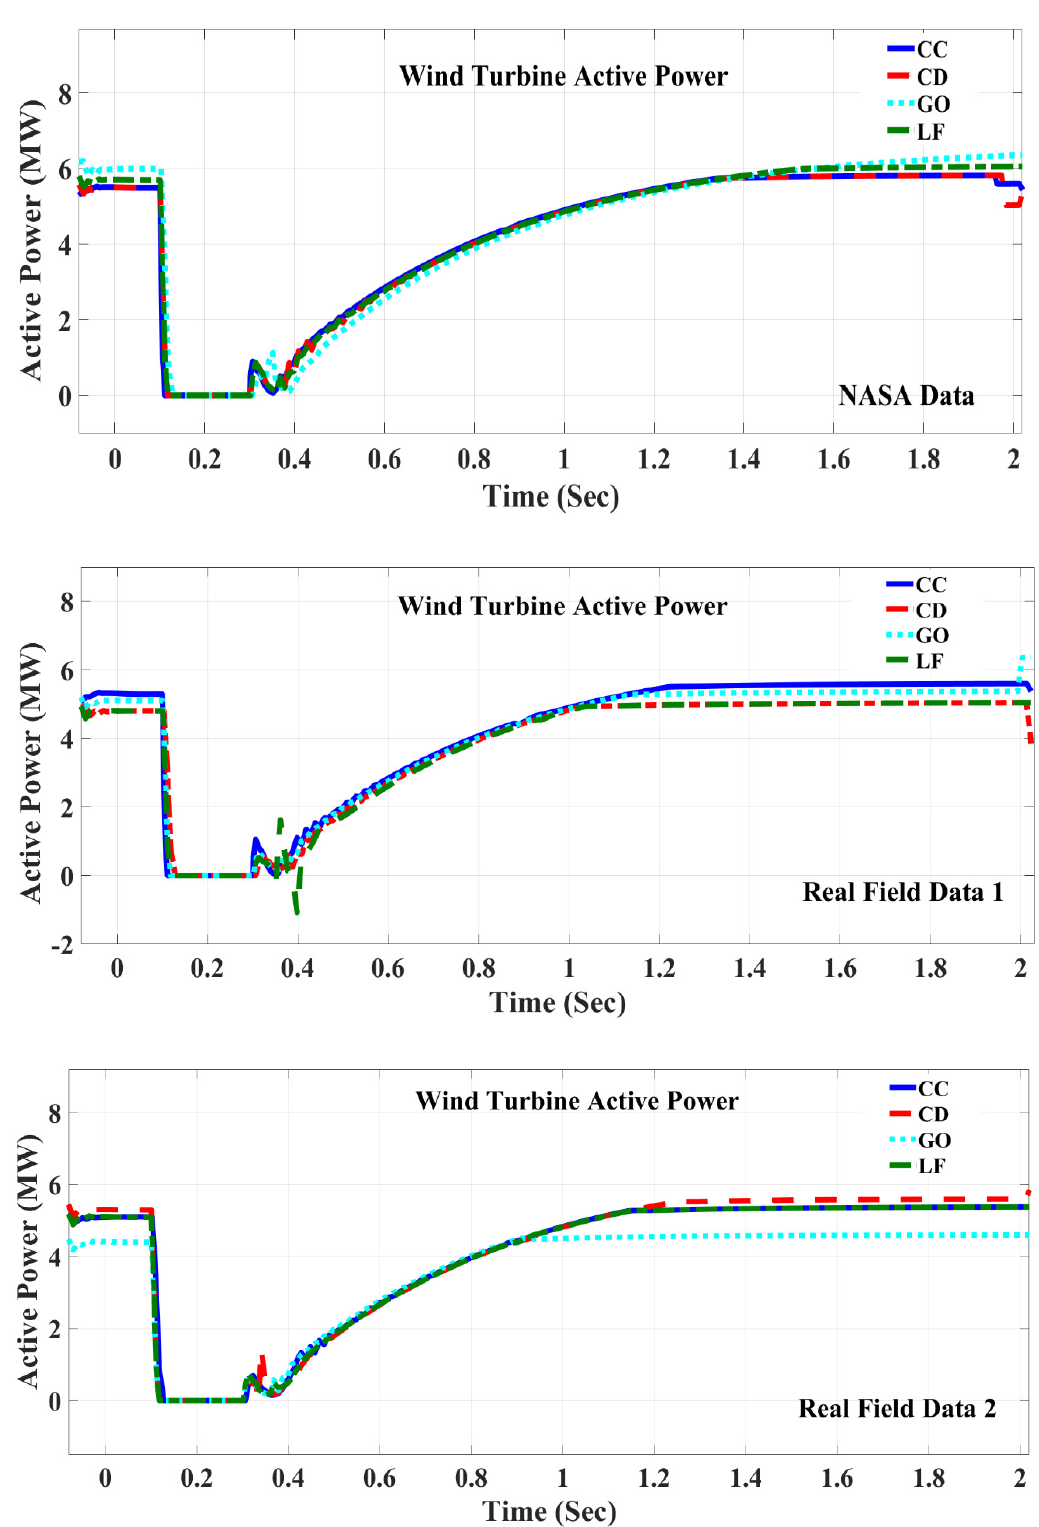
Figure 11. Active power responses of wind turbine generator at Bus 1 for four dispatch strategies. Under the CC, BESS is usually charged by the diesel generator and other generators supply power to meet the load demand. PV and wind-generator active powers are the highest under LF, which denotes the maximum power interjection from the